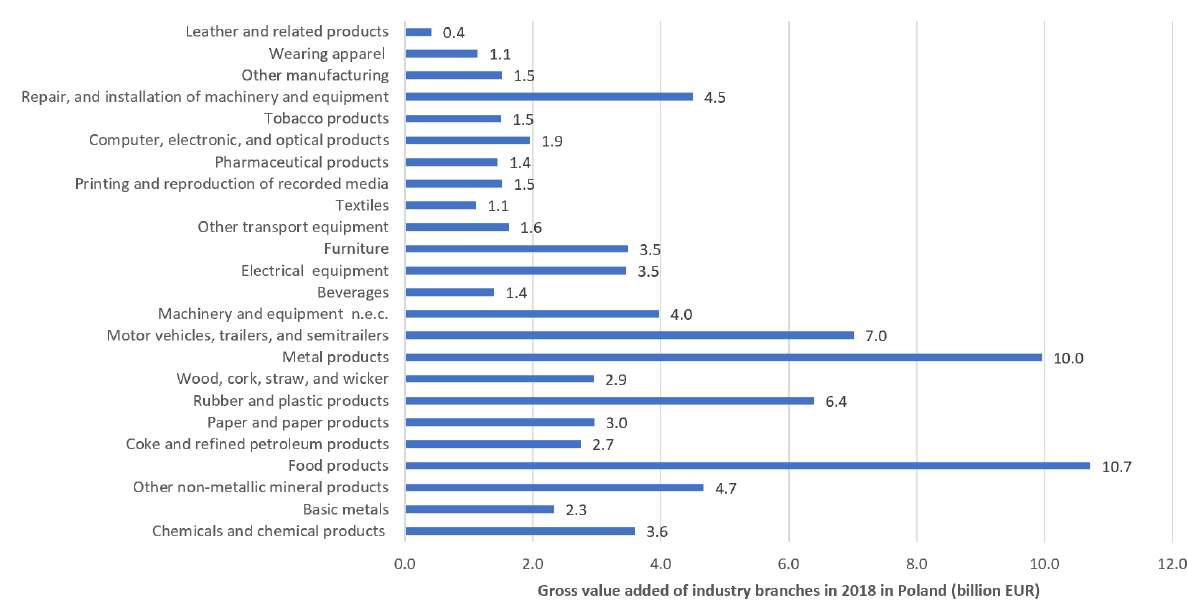
Figure 2. Gross value added of industry branches in 2018 in Poland (billion EUR). Manufacturing overall: 104.1 billion EUR (own study based on Statistics Poland report [38]).